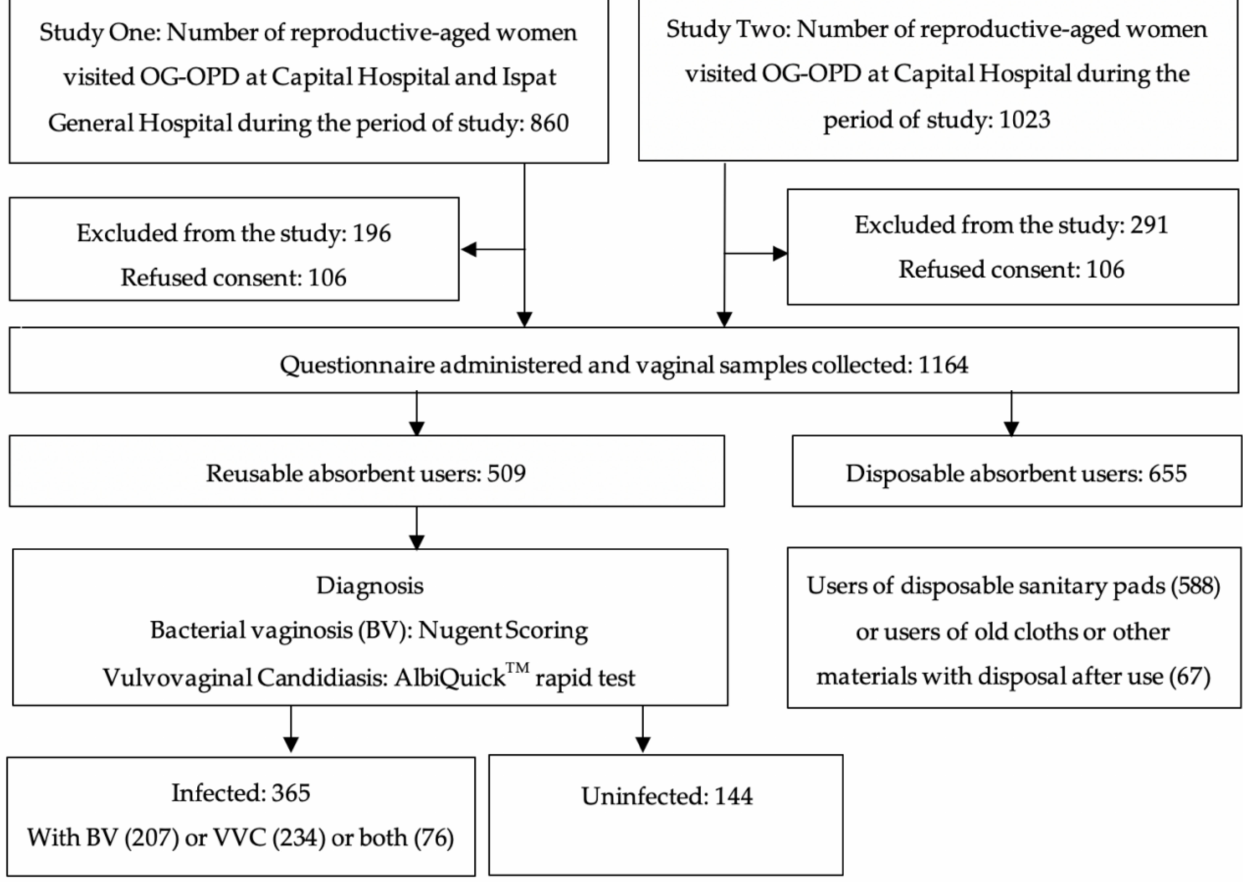
Figure 2. Schematic diagram for recruitment, enrollment, analysis inclusion, outcome diagnosis, and inclusion in the